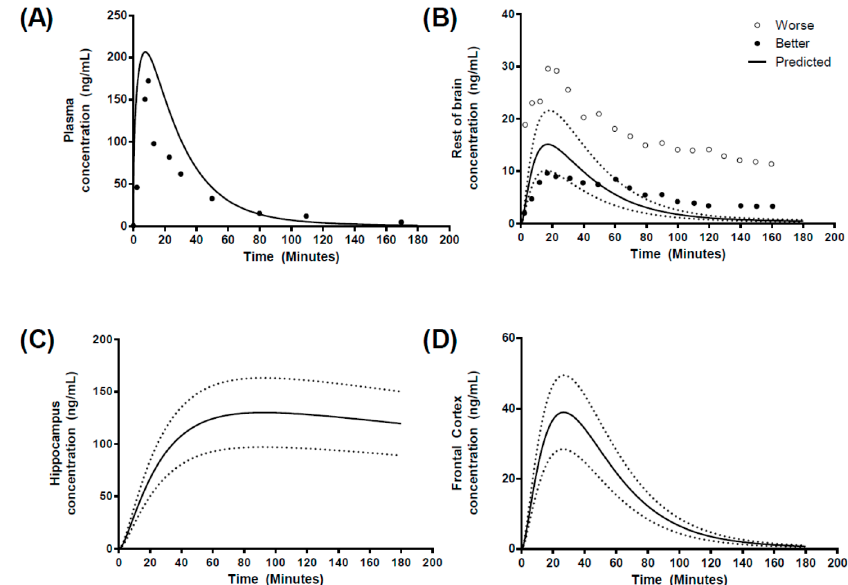
Figure 8. Simulated human morphine concentration-time profiles. Predicted concentration-time profiles for ( A ) plasma, ( B ) rest of brain, ( C ) hippocampus and ( D ) frontal cortex, following a 10 mg IV-infusion over 10 min. Circles represent literature reported values. Solid black line represents model prediction mean profiles and dashed lines indicated 5th and 9th percentiles. “Better” and “worse” regional brain morphine concentrations are highlighted by solid or open circles in ( B ).